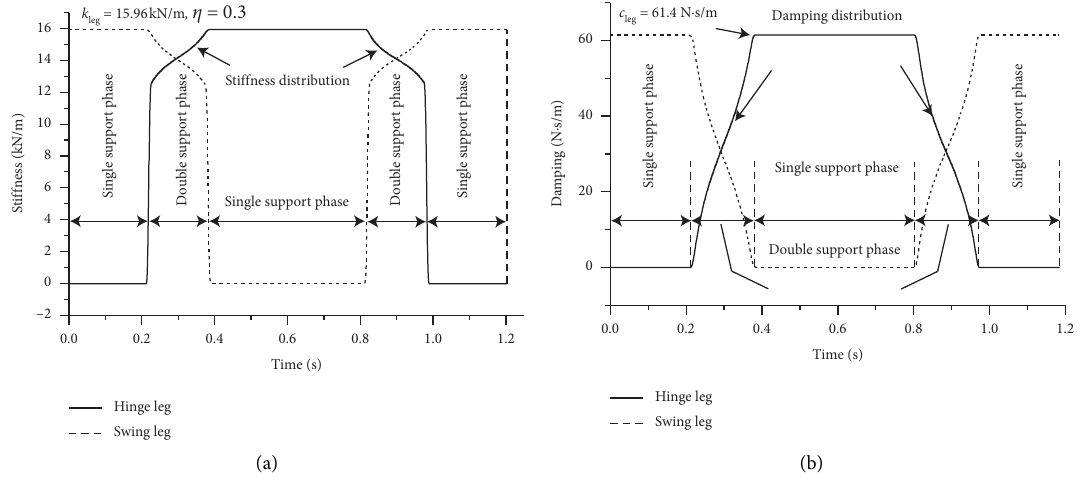
Figure 14: (a) Leg stiffness coefficients. (b) Leg damping